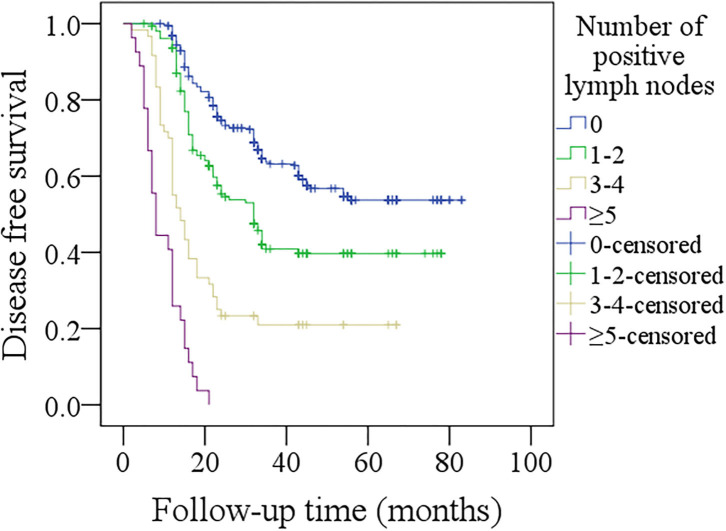
Comparison of disease-free survival among p16 negative patients with different numbers of positive lymph nodes (p < 0.001).